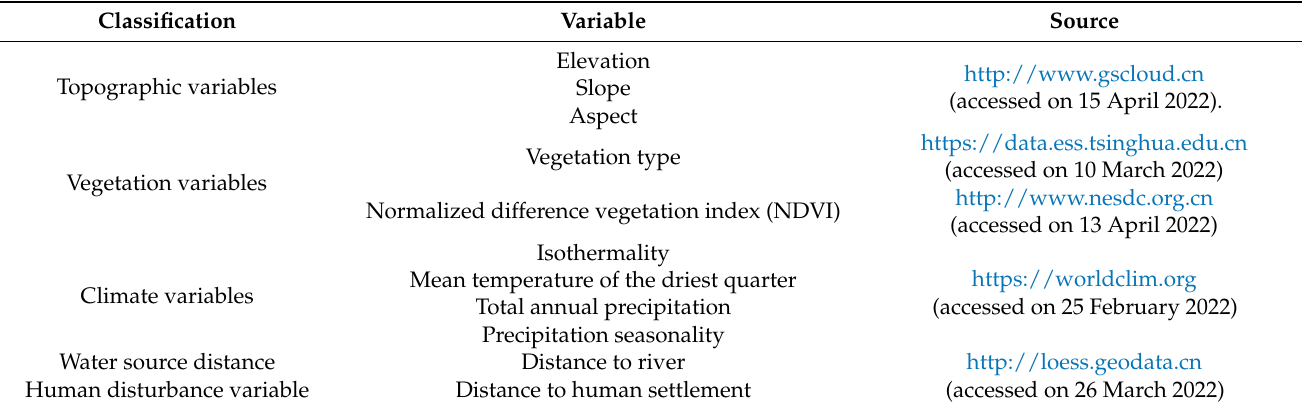
Table 1. Environmental factors involved in model operation and their